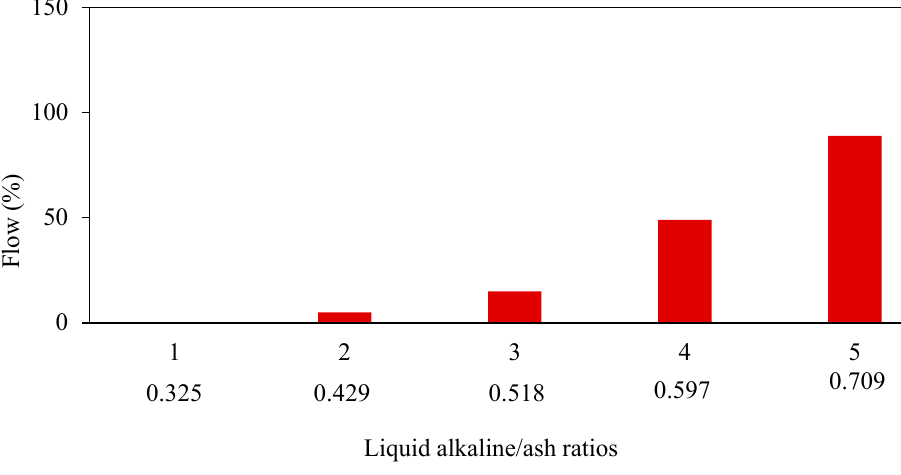
Figure 5. The flow of mortar with various BA fineness [36].